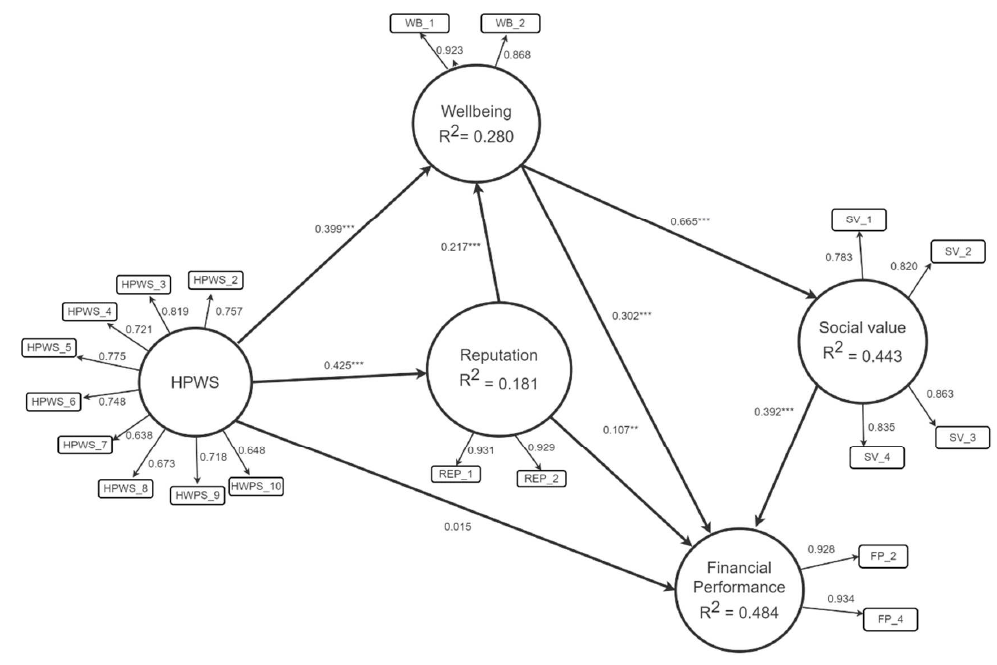
Figure 2. Model results. (Source: Own based on SmartPLS); p ** < 0.01; p *** < 0.001.